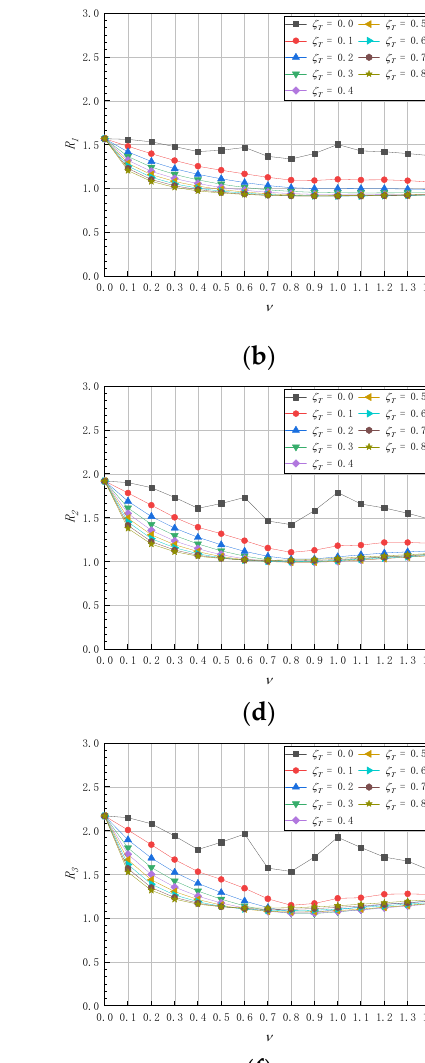
Figure 9. Responses of the ( a , c , e ) 1st, 2nd and 3rd story of the substructure and ( b , d , f ) main struc ‐ ture of a three ‐ story building.